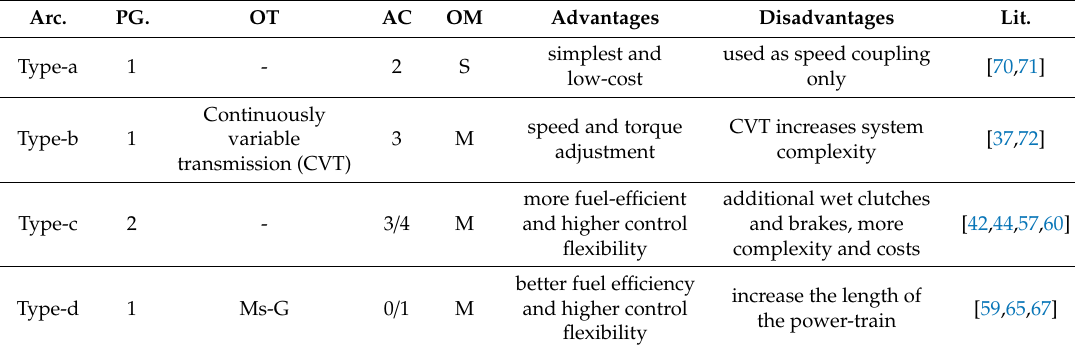
Table 4. Comparison of four types of SEM-PHPS architectures.